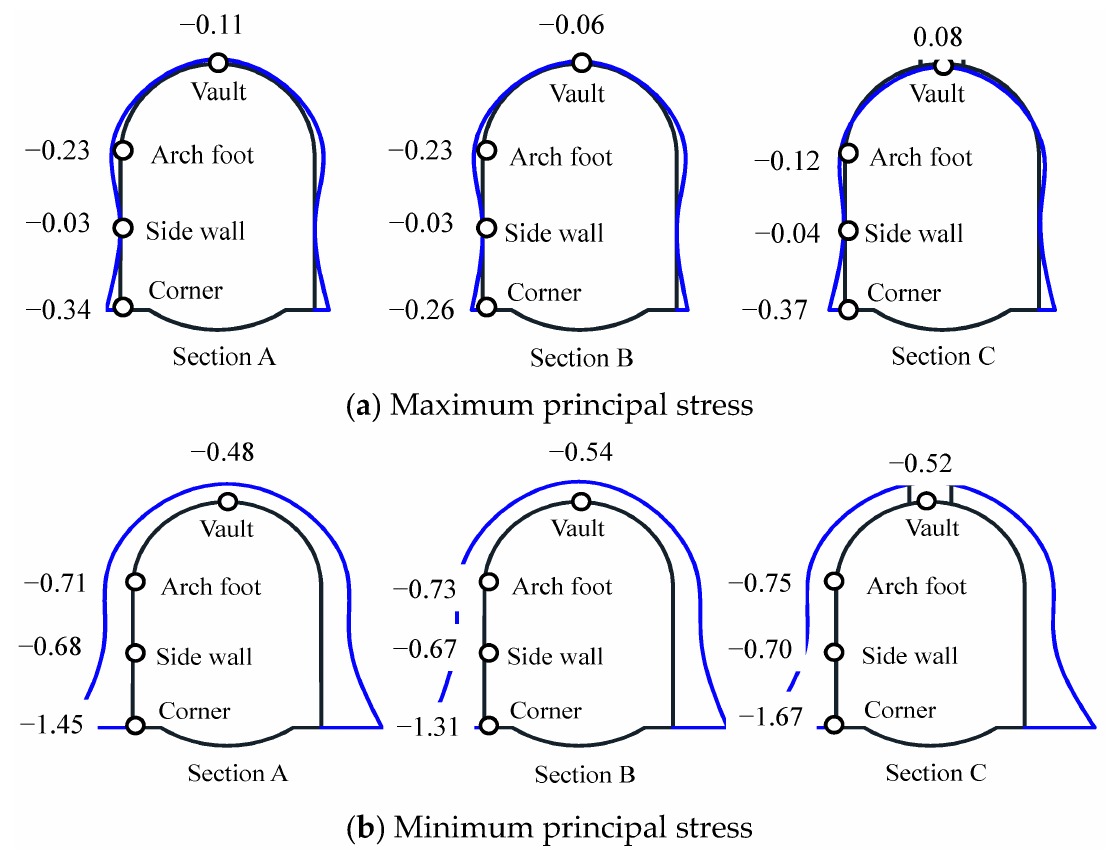
Figure 16. Principal stress of monitoring sections (unit: